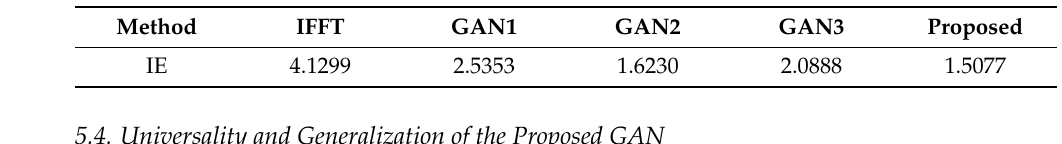
Table 7. Numerical performance evaluation for simulated aircraft under sparse aperture. Table 8. Numerical performance evaluation for Yak42 under sparse